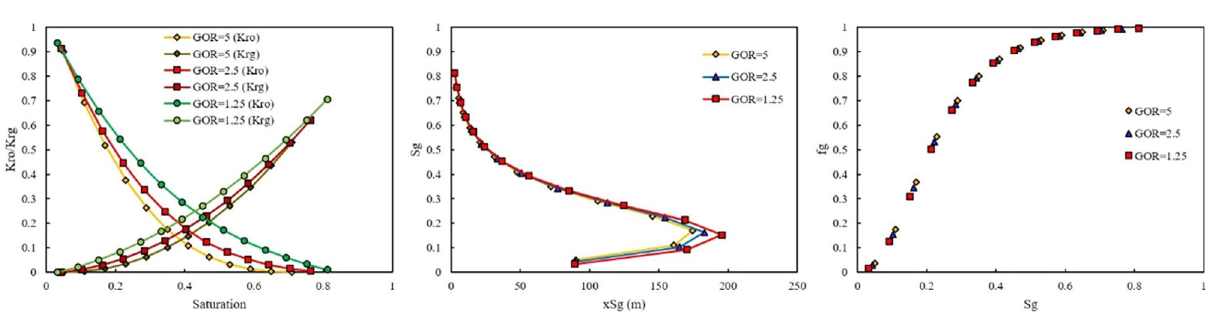
Figure 8. Effect of GOR of Naphtha on relative permeability, saturation profile, and fractional flow curve at an injection pressure of 500 psi.